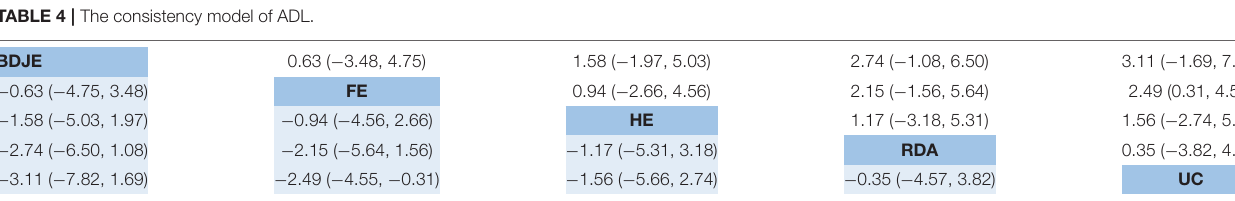
TABLE 4 | The consistency model of